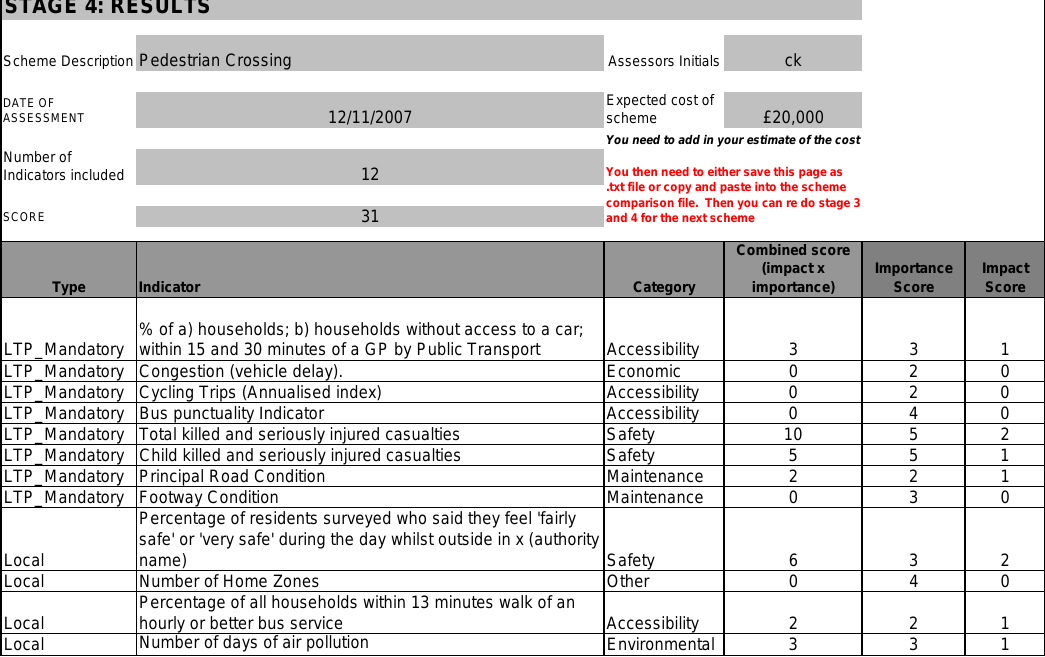
Figure 1. The results page – note that the calculation of the overall score (a simple sum of the combined scores) is